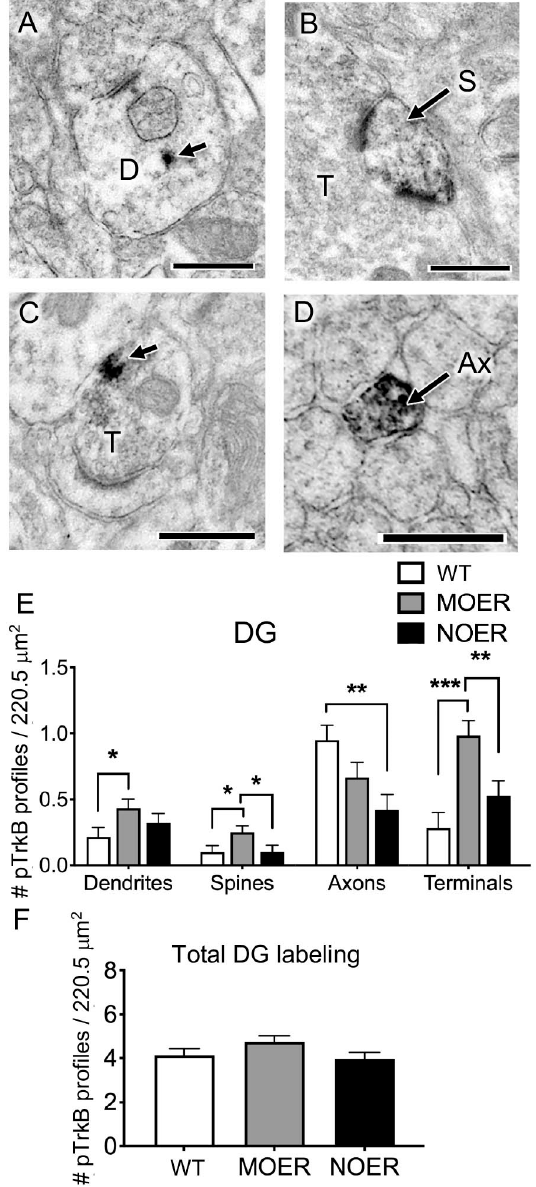
Figure 6. Ultrastructural distribution of pTrkB-labeled profiles in the DG of WT, MOER, and NOER female mice. ( A – D ) Examples of pTrkB labeling in a dendrite (D; A ), dendritic spine (S; B ), axon terminal (T; C ), and axon (Ax; D ) from MOER ( A – C ) and control ( D ). Punctate pTrkB labeling was found in the cytoplasm of the dendrite (arrow, A ) and near the plasma membrane of the terminal (arrow, C ). Photos from MOER ( A – C ) and WT ( D ) mice. ( E ). Compared to WT mice, MOER mice had significantly more pTrkB-labeled dendrites. Moreover, compared to both WT and NOER mice, MOER mice had more pTrkB-labeled dendritic spines and terminals. However, WT mice had significantly greater pTrkB-labeled axons than NOER mice. ( F ). Total pTrkB-labeled profiles in the DG were not significantly different among WT, MOER, and NOER mice ( n = 3 mice per condition); * p < 0.05, ** p < 0.005, *** p < 0.0001; scale bar = 500 nm. In the CA1, one-way ANOVA, showed a significant genotype effect on the number of pTrkB-labeled dendrites (F(2179) = 5.670; p = 0.0041) and axons (F(2179) = 10.1883; p < 0.0001). A post hoc Student’s t -test revealed that WT animals had significantly more pTrkB-labeled dendritic profiles compared to MOER ( p = 0.0019) and NOER ( p = 0.0096) mice (Figure 5C). Likewise, WT mice had significantly more pTrKB-labeled axons